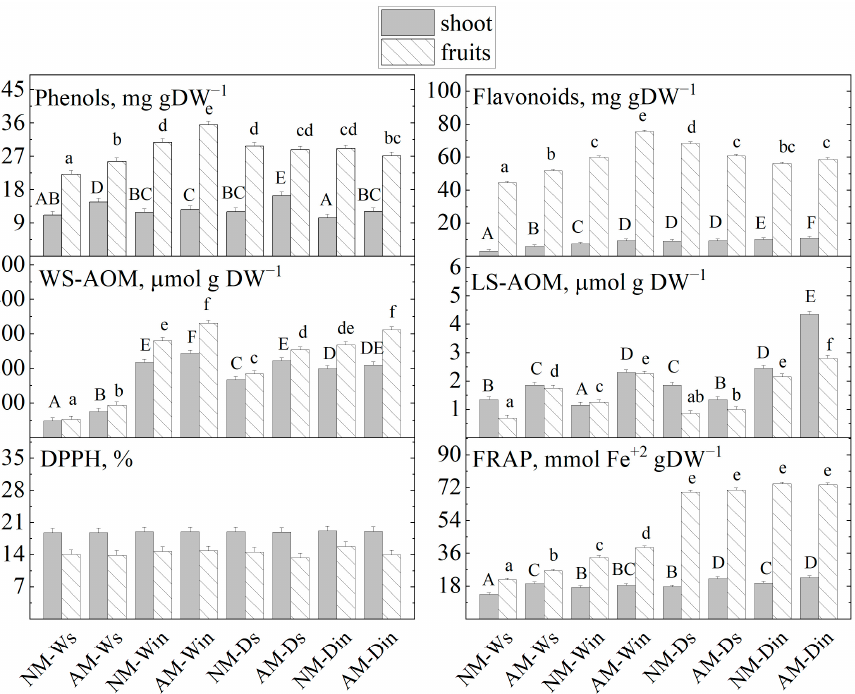
Figure 5. Metabolites with antioxidant power and total antioxidant potential in P. peruviana (leaves and fruit): non-mycorrhizal ( NM ), AMF-inoculated ( AM ), well-watered ( W ), drought-stressed ( D ), seed-propagated ( s ) and in vitro propagated ( in ) plants. Values are mean ± SE, n = 3; different letters indicate significant differences as assessed by Fisher LSD test ( p ≤ 0.05) after performing ANOVA multi-factor analysis. The statistical analyses of leaves (uppercase) and fruit (lowercase) were performed separately.